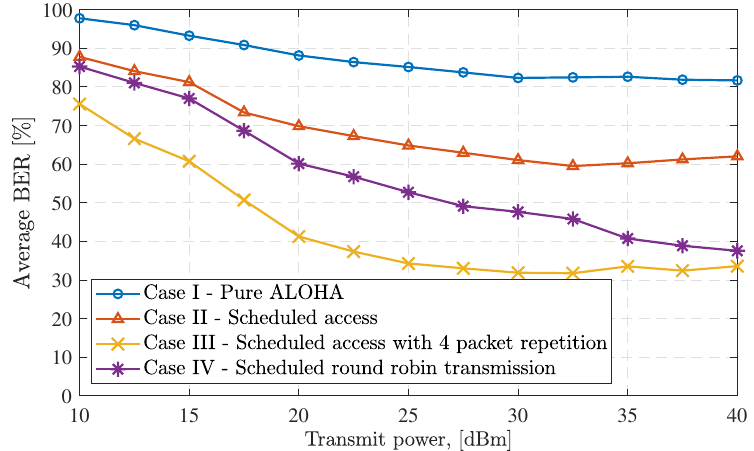
Figure 12. The average BER as a function of the transmit power for different access cases. The constellation size and altitude are equal to N s = 480, h = 550 km, respectively.